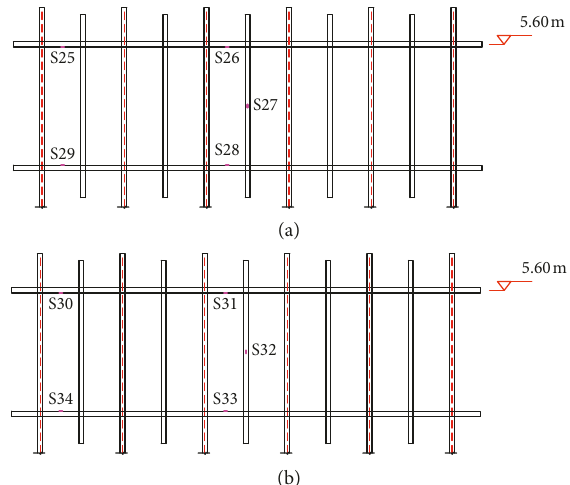
Figure 12: Layout of strain gauges on horizontal rods in Model 3. (a) A-axis horizontal beam. (b) C-axis horizontal beam.